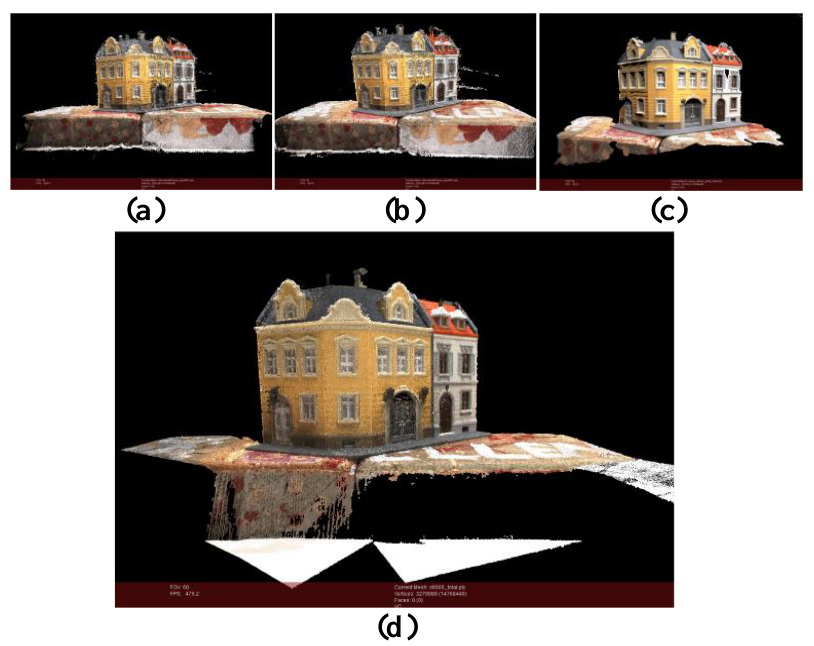
Figure 10. Point cloud comparison. ( a ) Point cloud of our method ( m = 15, k = 6); ( b ) Point cloud of openMVG + openMVS; ( c ) Point cloud of MicMac; ( d ) Standard point cloud. Distance histograms in Figure 12a–c are statistics results of distance point clouds in Figure 11a–c. For the house experiment, most distances are less than 1cm when the house is higher than 150 cm (the relative error is less than 1%).